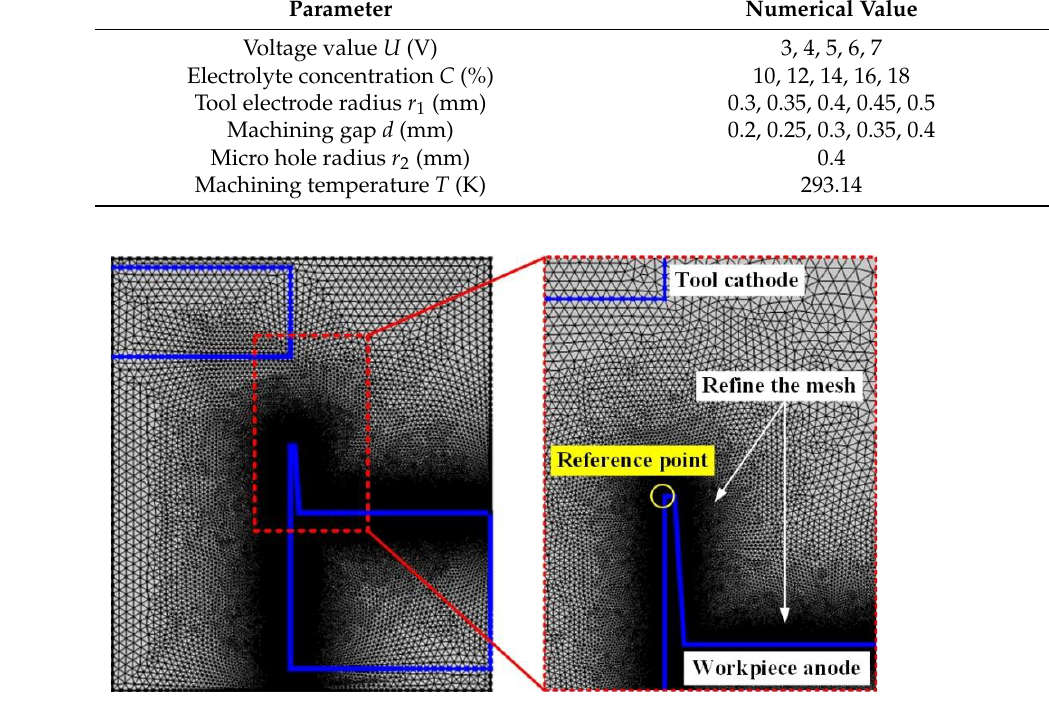
Figure 4. Mesh division.